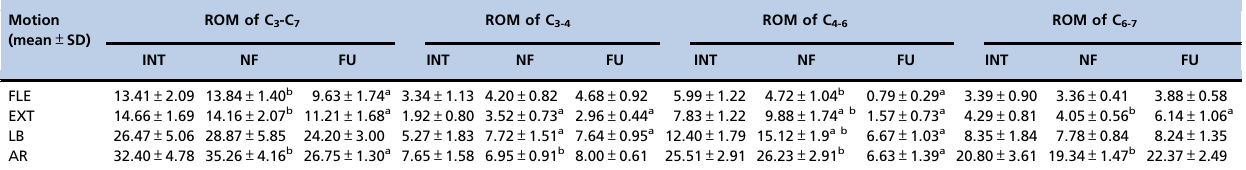
Table 2 - Average Range of Motion of the Specimens in the Intact, Non-Fusion and Fusion Groups in Response to the Maximum Applied Moment of 2 N (cid:1) m (in degrees).